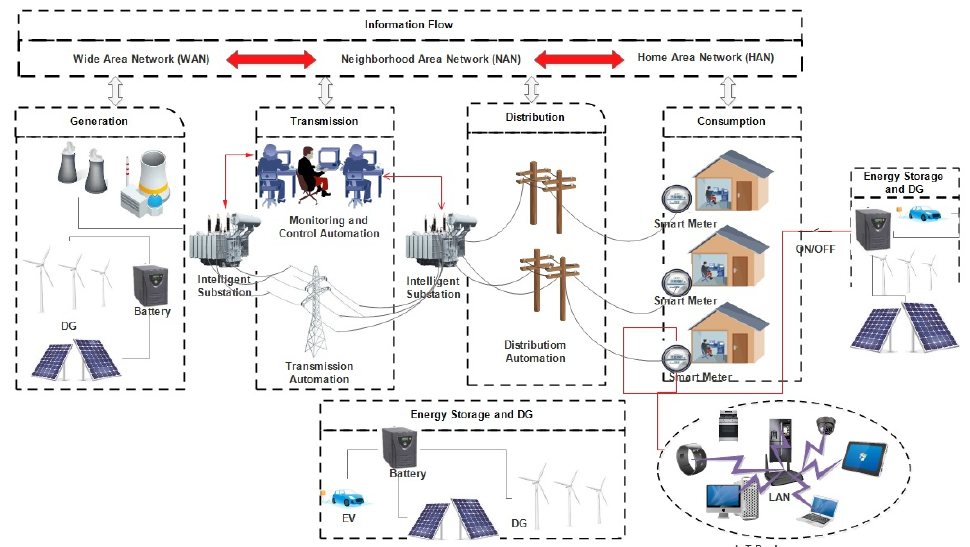
Figure 4. General smart grid